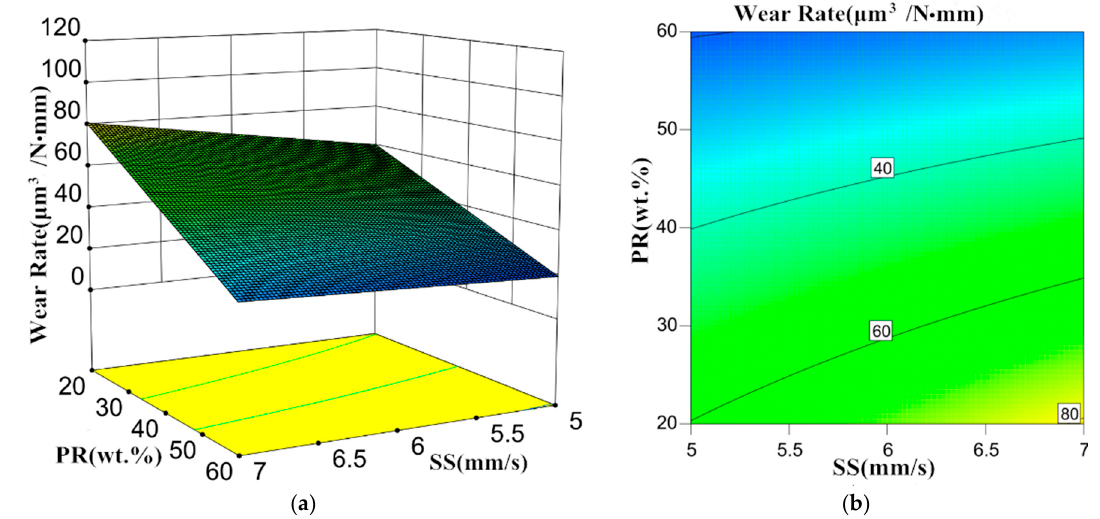
Figure 11. ( a ) 3D response curve of the interaction between SS and PR against wear rate; ( b ) Contour map of the interaction between SS and PR against wear rate.